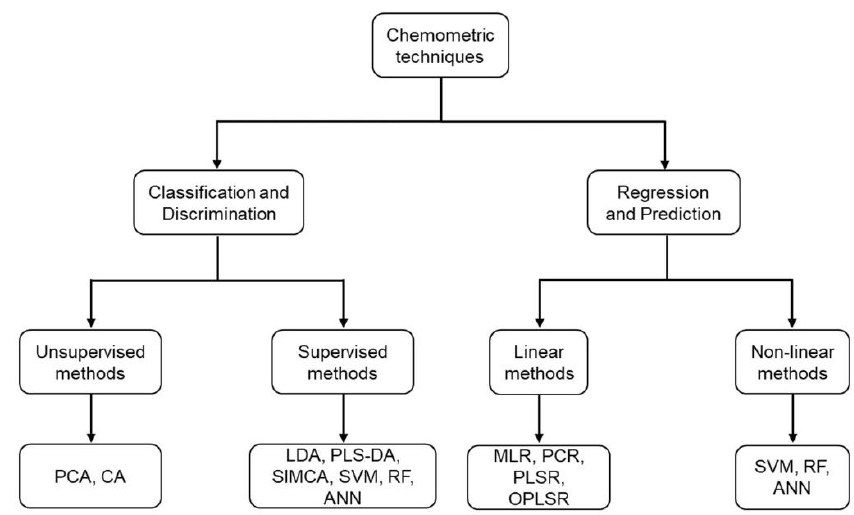
Figure 1. Classification of the chemometric techniques commonly used in food science.